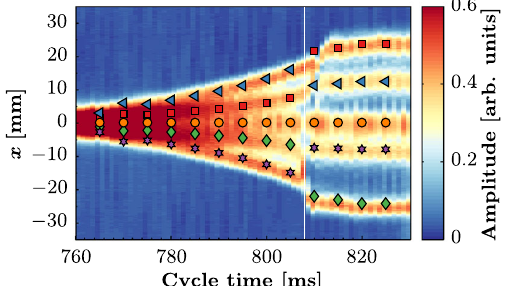
FIG. 11. Simulated horizontal phase space portraits in SS01 at the end of the splitting process in the absence of a tune ripple (top) and with a ripple amplitude corresponding to the maximum measured current ripple on the PFWs circuits (bottom). To quantify the effect on η , particles inside the red boundary MTE (drawn at (cid:2) 3 . 5 σ in x and x 0 ) are considered core particles. The core efficiency of the splitting process is clearly reduced by the presence of a tune